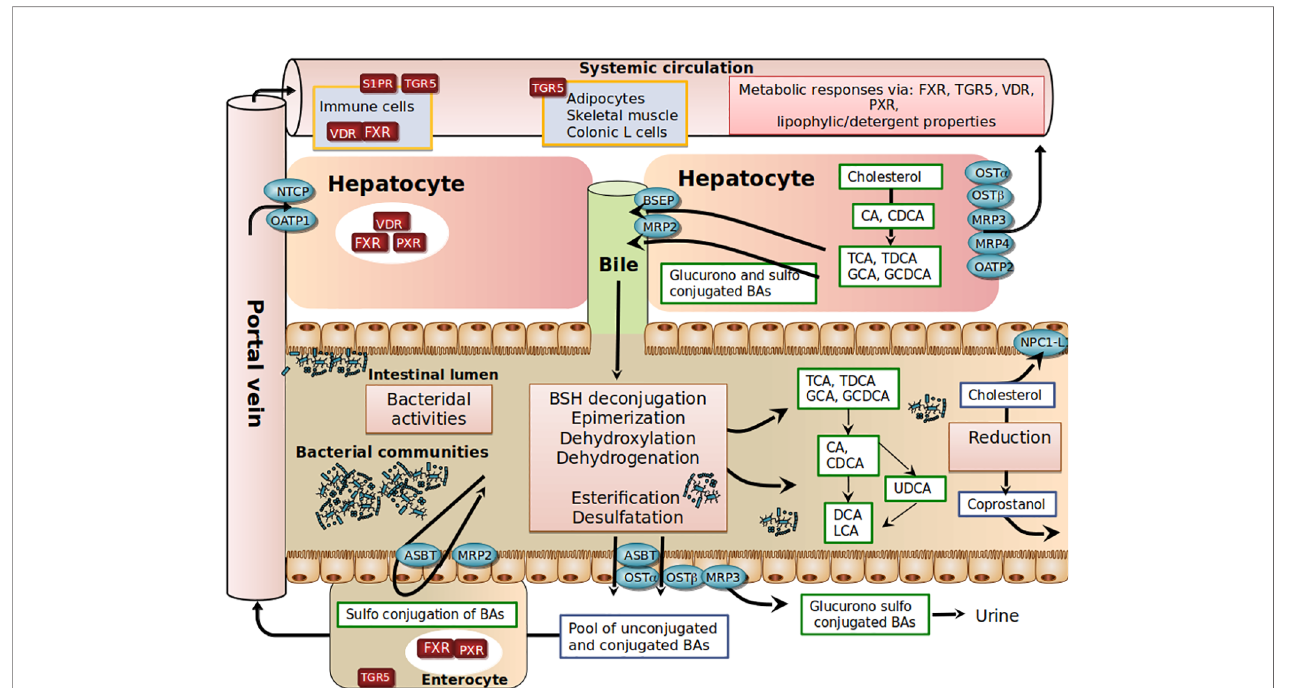
FIGURE 1 | Schematic view of host-gut microbial co-metabolism of bile acids and cholesterol in enterohepatic